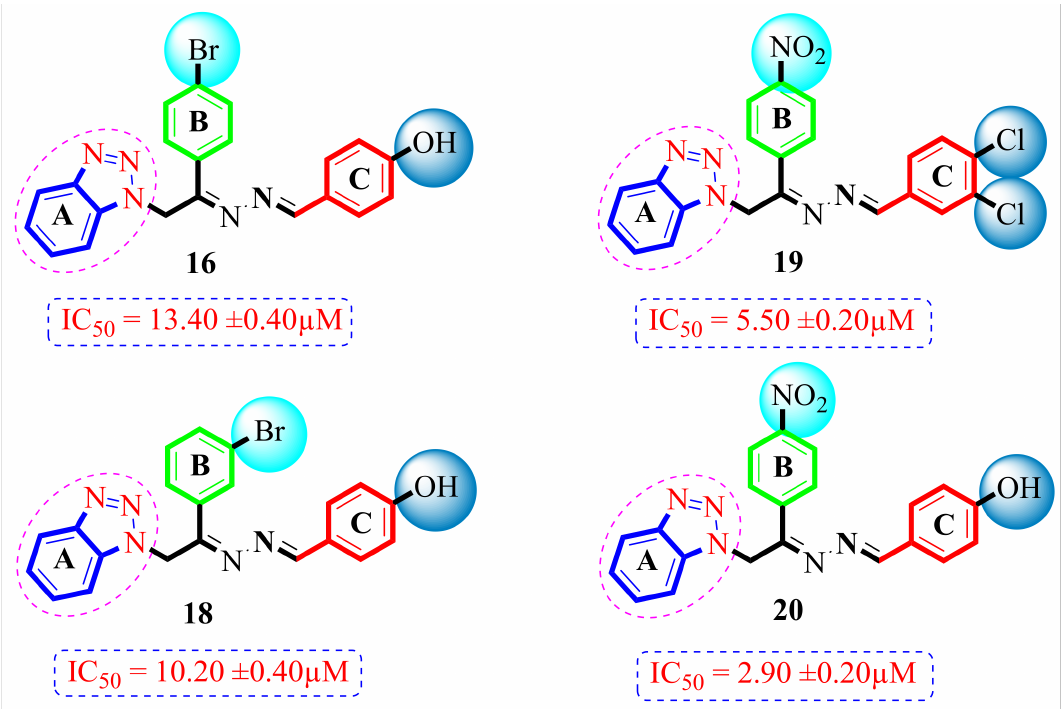
Figure 5. SAR study of scaffolds 16, 48, 19, and 20